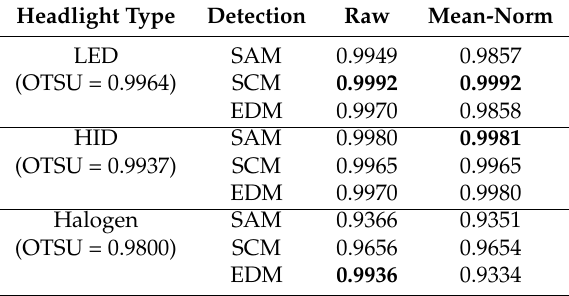
Table 2. AUC values in each headlight image (including combinations in each